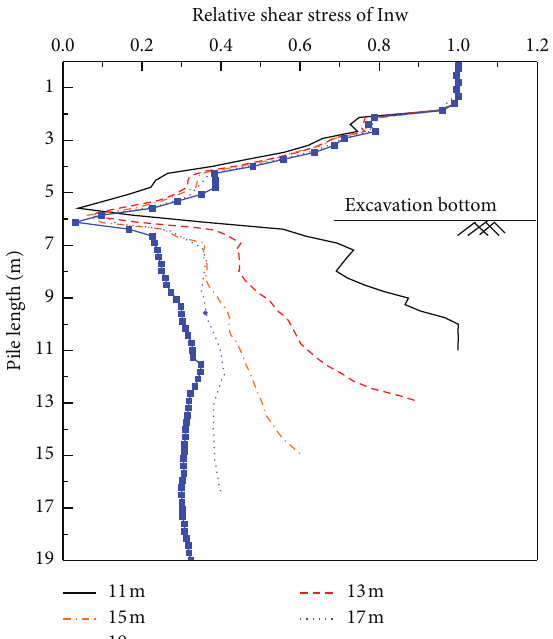
Figure 24: Comparison of the relative shear stress of inward-in- clined piles with different